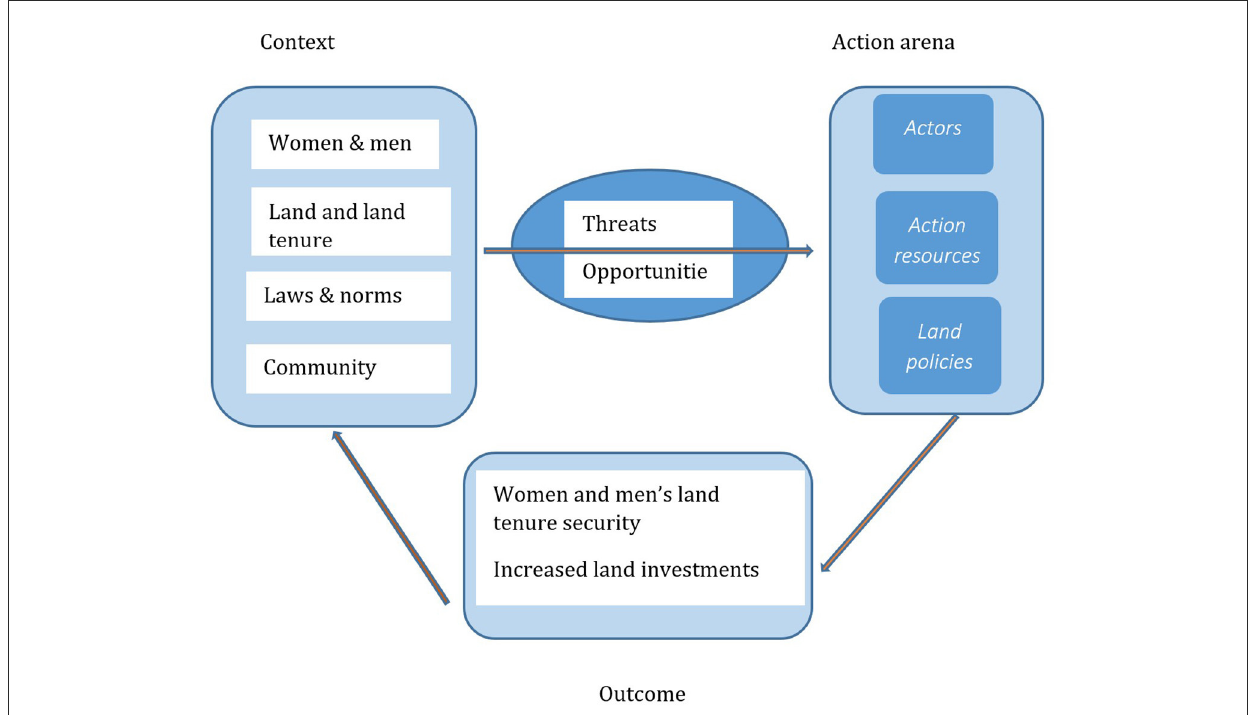
FIGURE1 Conceptual framework of factors affecting women and men’s land tenure security [adapted from (Doss and Meinzen-Dick,